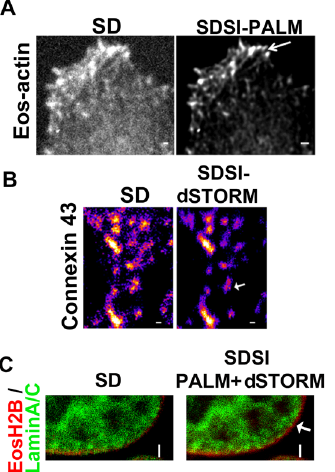
Figure 2. SDSI super resolution imaging using both PALM and STORM. (A) Comparison of SD and PALM images (processed by SOFI) of Eos-Actin, (B) Comparison of SD and d-STORM images of Connexin 43, Secondary Fab fragment antibodies conjugated to AlexaFluor647 were used for dSTORM imaging, SR data was generated using 3 rd order SOFI, in both images bar=1 m m. (C) Comparison of SD and SDSI combining PALM and dSTORM imaging of Eos-Histone 2B (PALM) and Lamin A/C (dSTORM). Secondary Fab fragment antibodies conjugated to AlexaFluor647 were used for dSTORM imaging. SR data was generated using 3 rd order SOFI. Arrow indicates individual histone complexes, bar=2 m m.